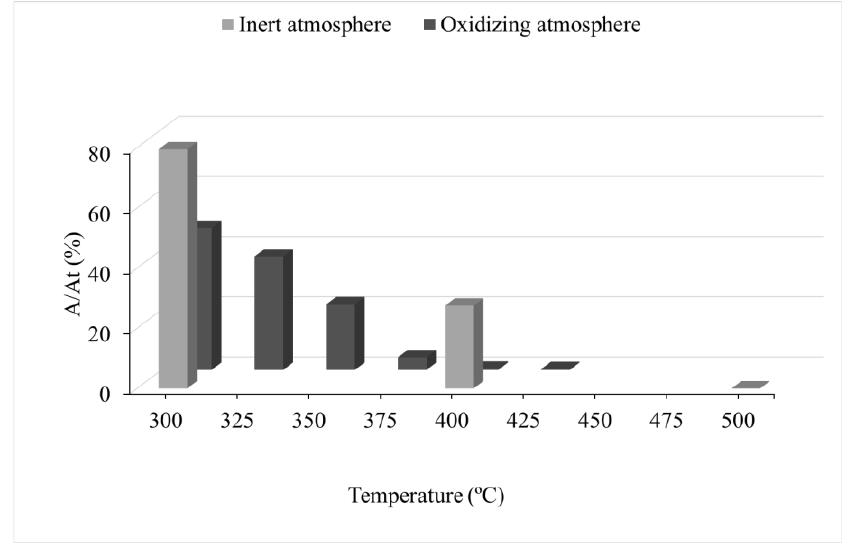
Figure 8. Evolution of NNN with temperature in the He and air atmospheres.